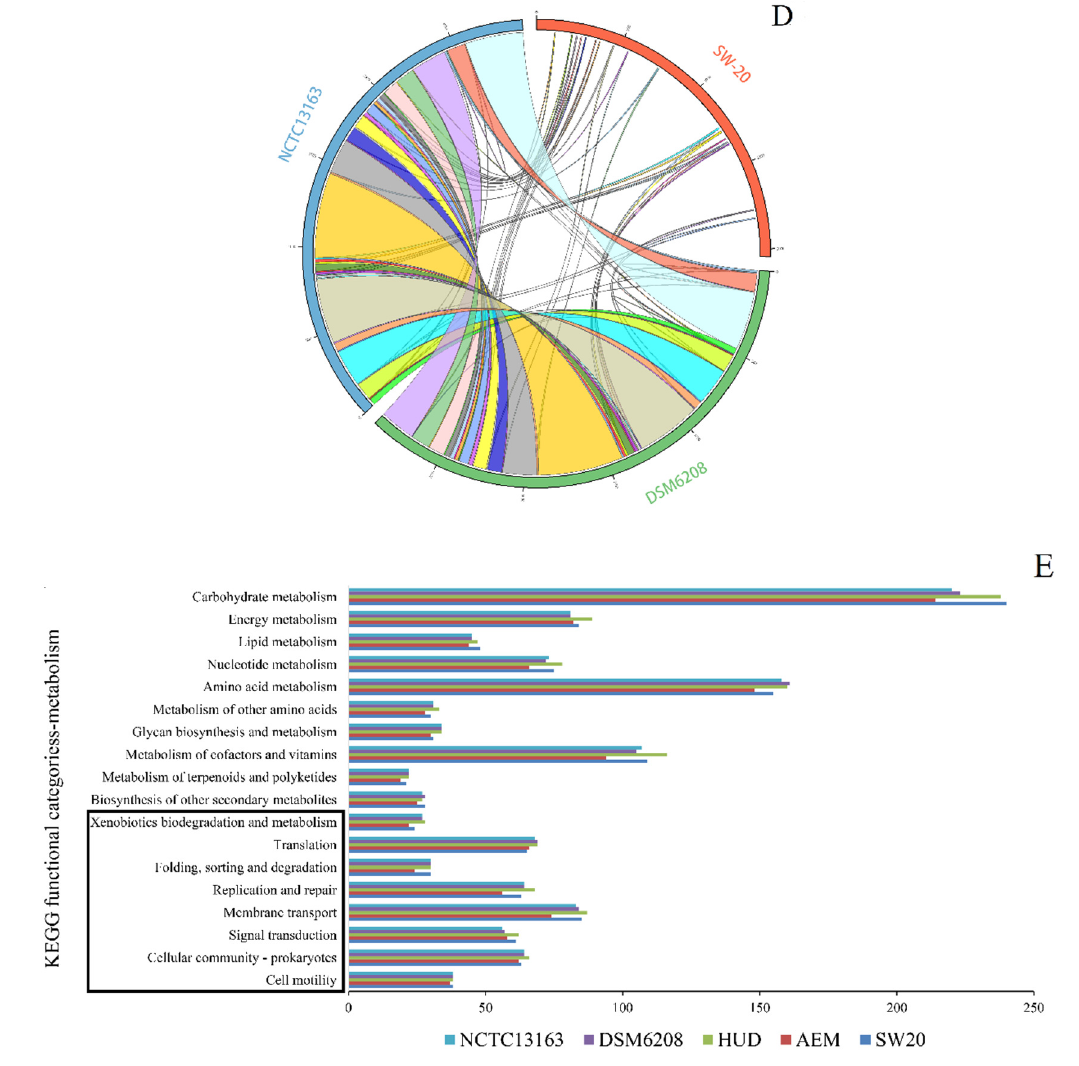
Figure 4. Analysis of orthologous genes and genomic synteny in E. aurantiacum SW-20, E. aurantiacum DSM 6208, E. aurantiacum NCTC13163, E. mexicanum A-EM and E. mexicanum HUD ( A ) Venn diagram represents distribution of shared and unique gene clusters among SW-20, A-EM and HUD ( B ) Venn diagram represents distribution of shared and unique gene clusters among SW-20, DSM 6208 and NCTC13163 ( C ) Genomic synteny shared between SW-20, A-EM and HUD. (For interpretation of the references to color in this figure legend, the reader is referred to the web version of this article.) ( D ) Genomic synteny shared between SW-20, DSM 6208 and NCTC13163. (For interpretation of the references to color in this figure legend, the reader is referred to the web version of this article.) ( E ) KEGG pathway enrichment analysis represented through bar chart shows distribution of number of proteins in 18 different KEGG metabolic function categories annotated using the